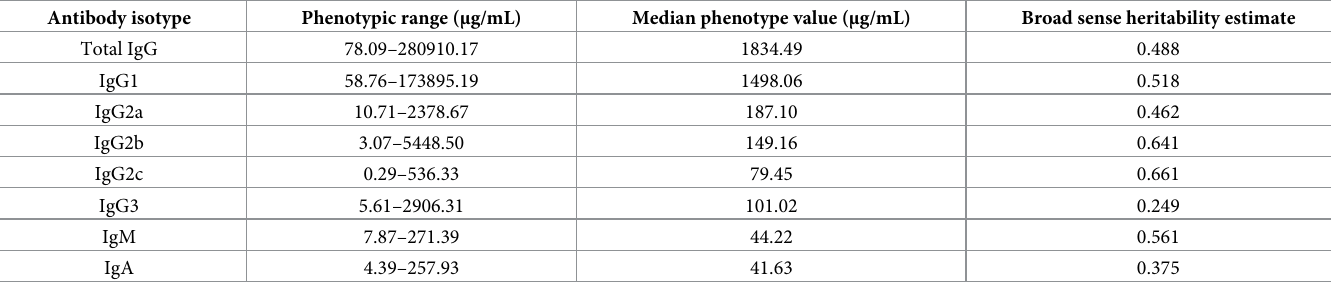
Table 1. Homeostatic antibody serum concentration ranges and broad sense heritability estimates. Antibody